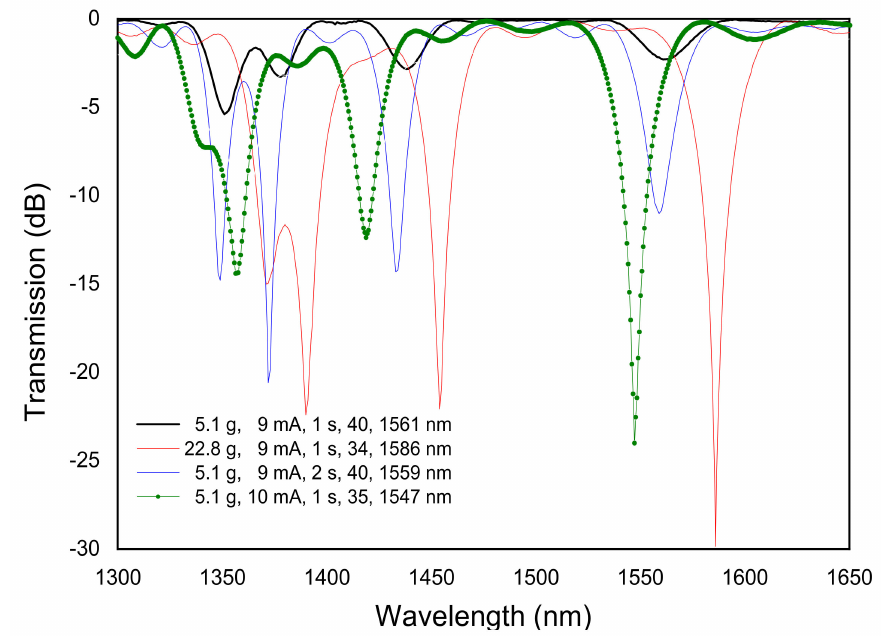
Figure 4. Influence of the fabrication parameters on LPFGs arc-induced in the SMF28 fiber. Adapted with permission from ref. [82]. © 2005 Taylor &